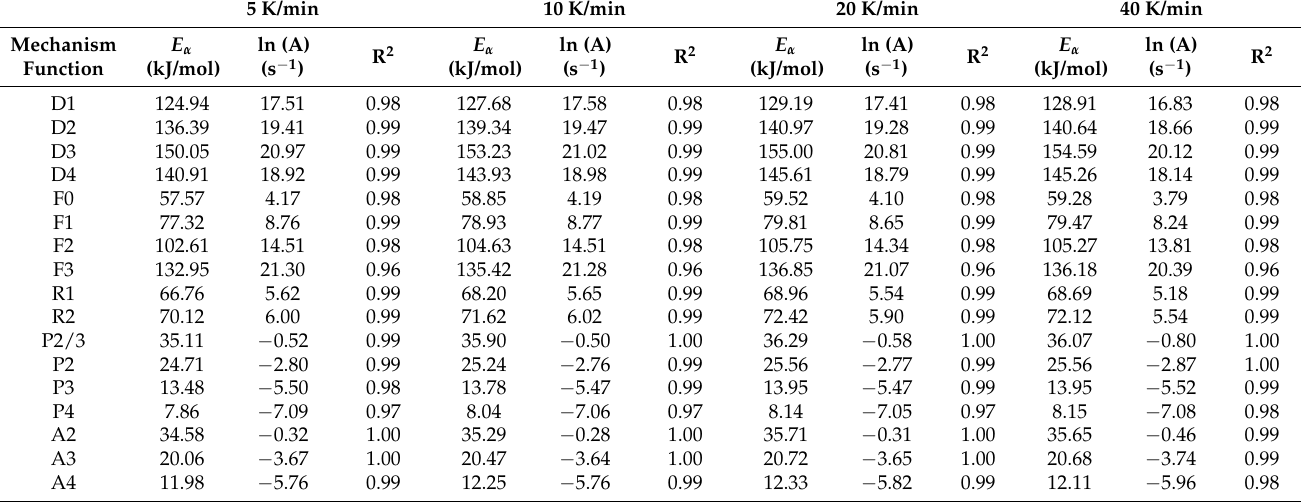
Table 5. Activation Energy and ln A of Natural Aging—70 Chinese Fir under Different Mechanism